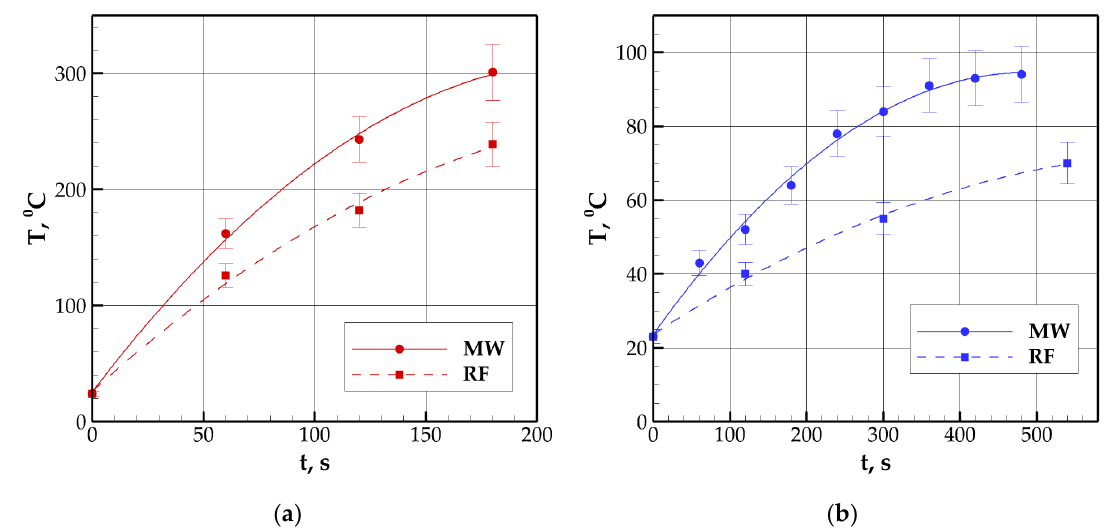
Figure 5. Heating dynamics in both microwave and radio-frequency fields of ( a ) the Bazhenov Formation sample B5 and ( b ) the Domanik Formation sample D5.